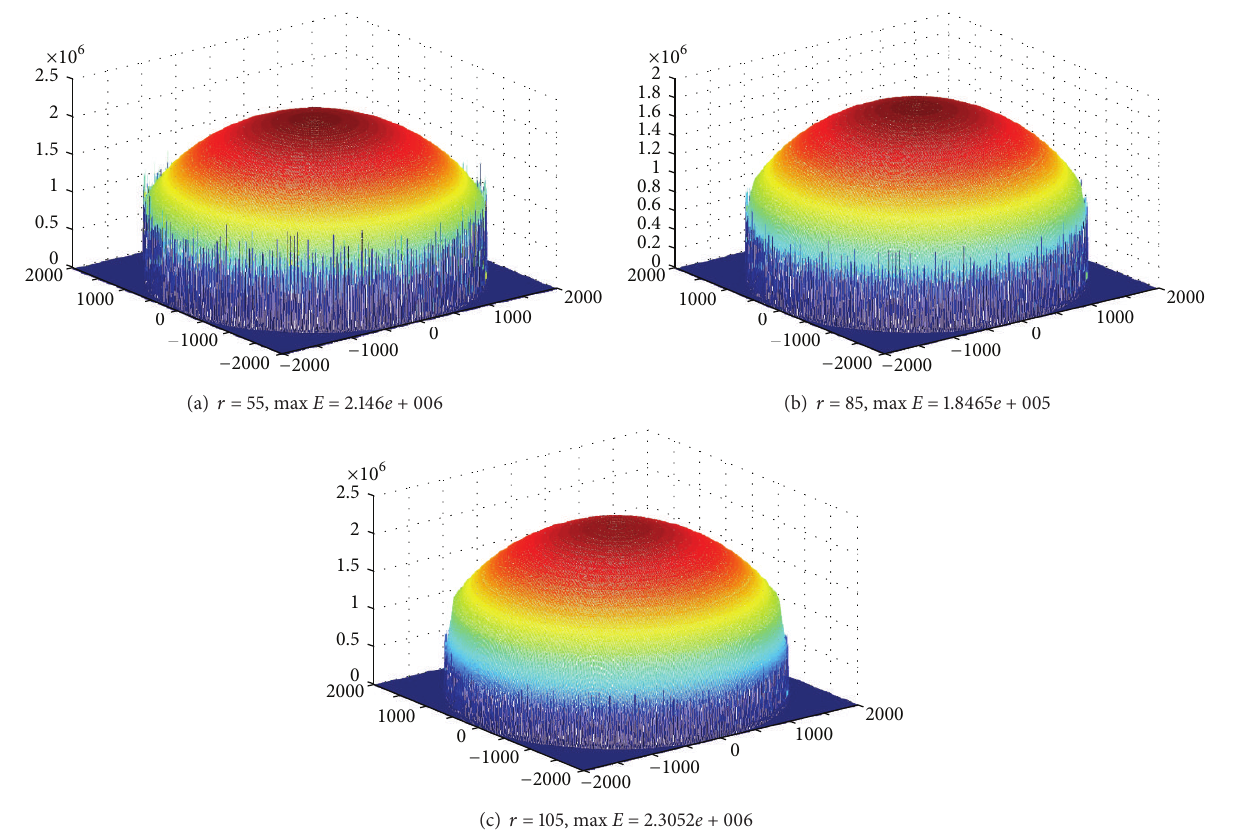
Figure 14: The largest energy consumption of mobile sink network under different 𝑟 ( 𝑅 = 2000 m, 𝑅 𝑚 = 2000 m, rounds = 300, anchors = 300).